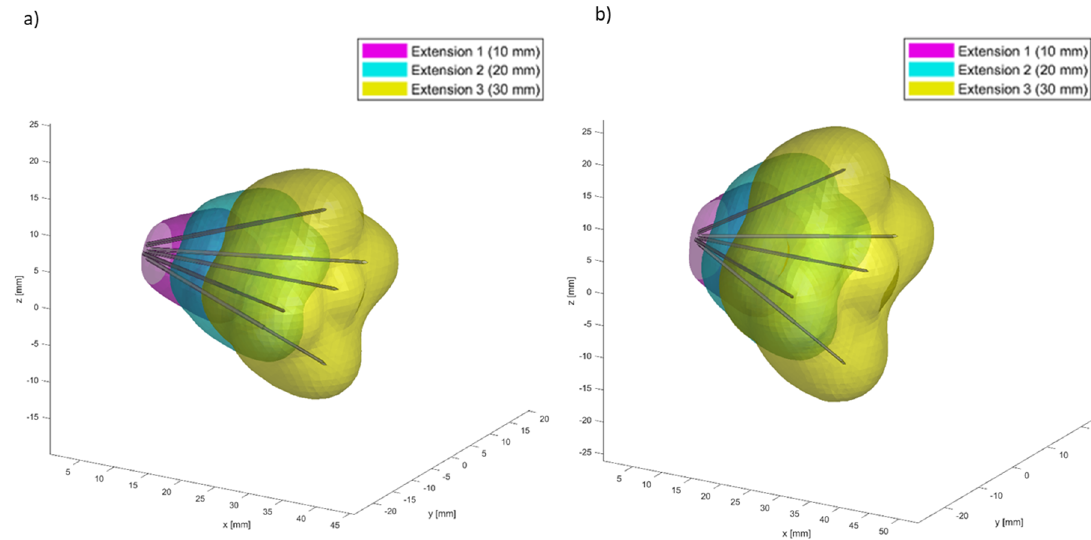
Figure 3. Finite Element Method (FEM) simulations for a deployable expandable electrode with a divergence angle of ( a ) 20° and of ( b ) 30° considering three electroporation steps (10 mm, 20 mm, and 30 mm).